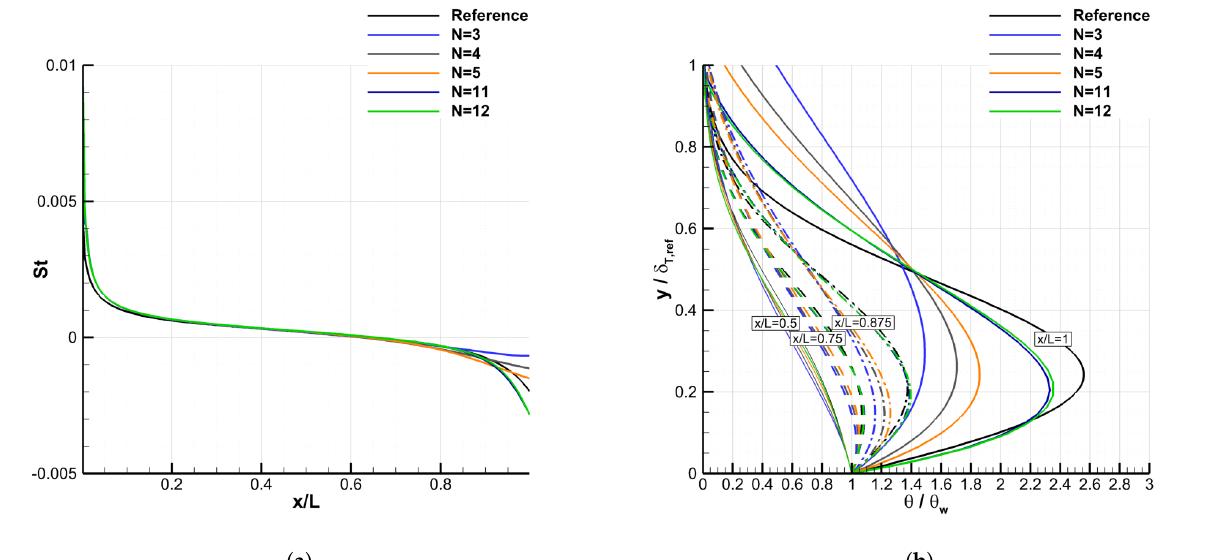
Figure 18. ( a ) Stanton number and ( b ) temperature profiles for several x / L locations. Test case 4, m = − 0.01961. N = 3 to N = 12, N x =